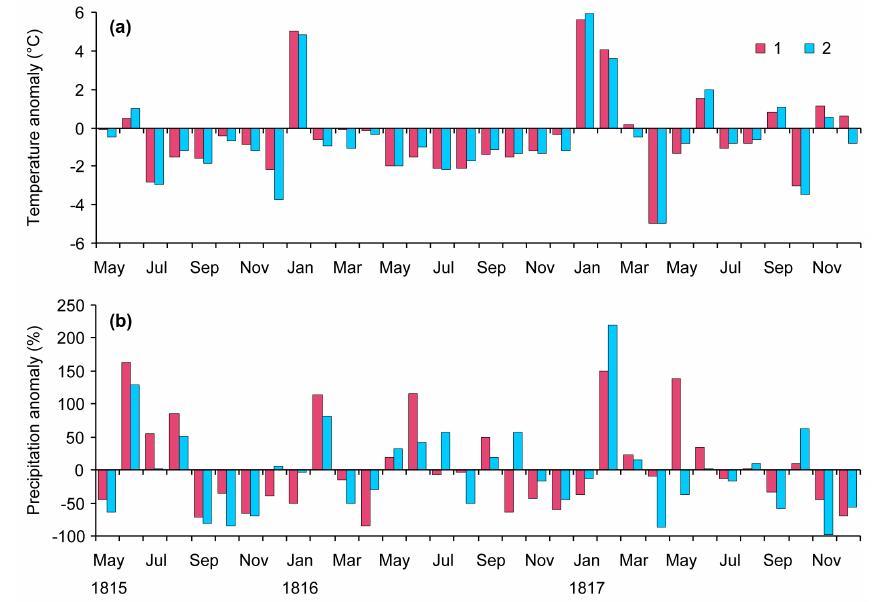
Figure 3. Monthly temperature (a) and precipitation (b) anomalies in Prague-Klementinum (1) and Brno (2) series after the Tambora eruption (May 1815–December 1817). Anomalies are expressed with respect to the 5-year pre-eruption period.